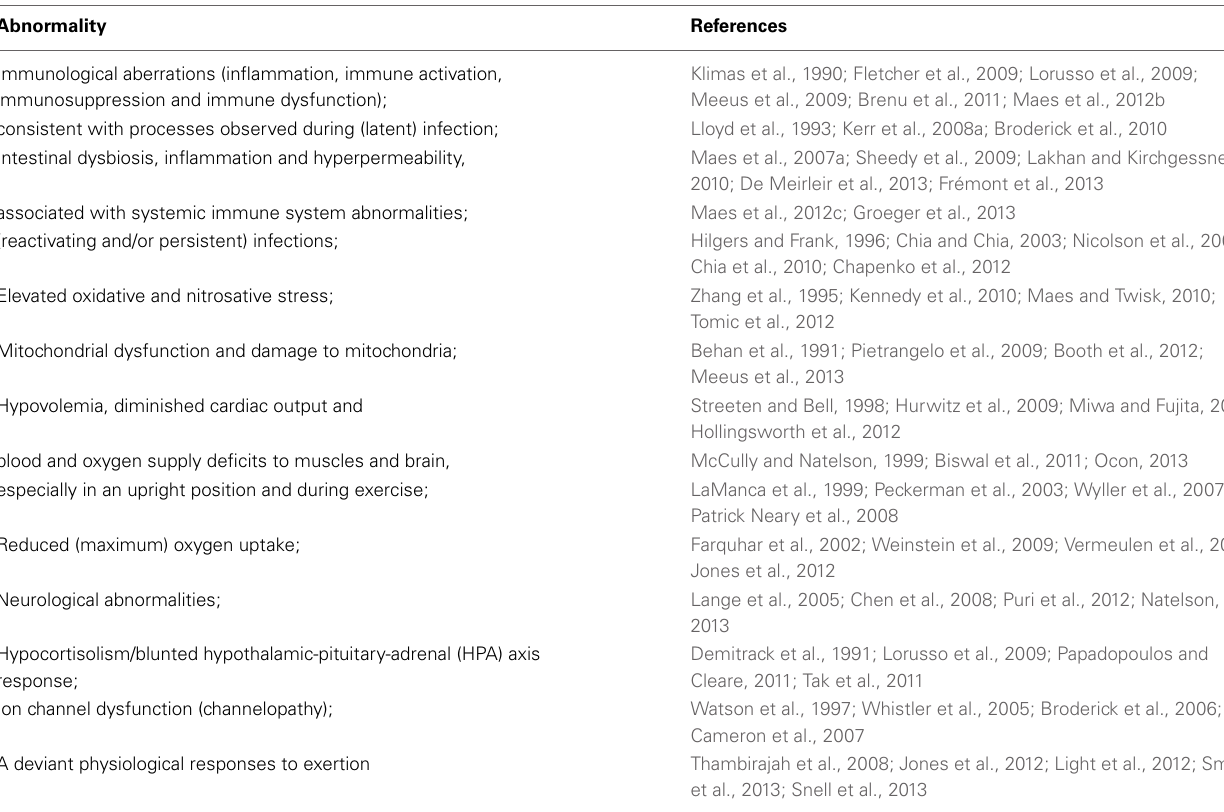
Table 2 | Abnormalities in